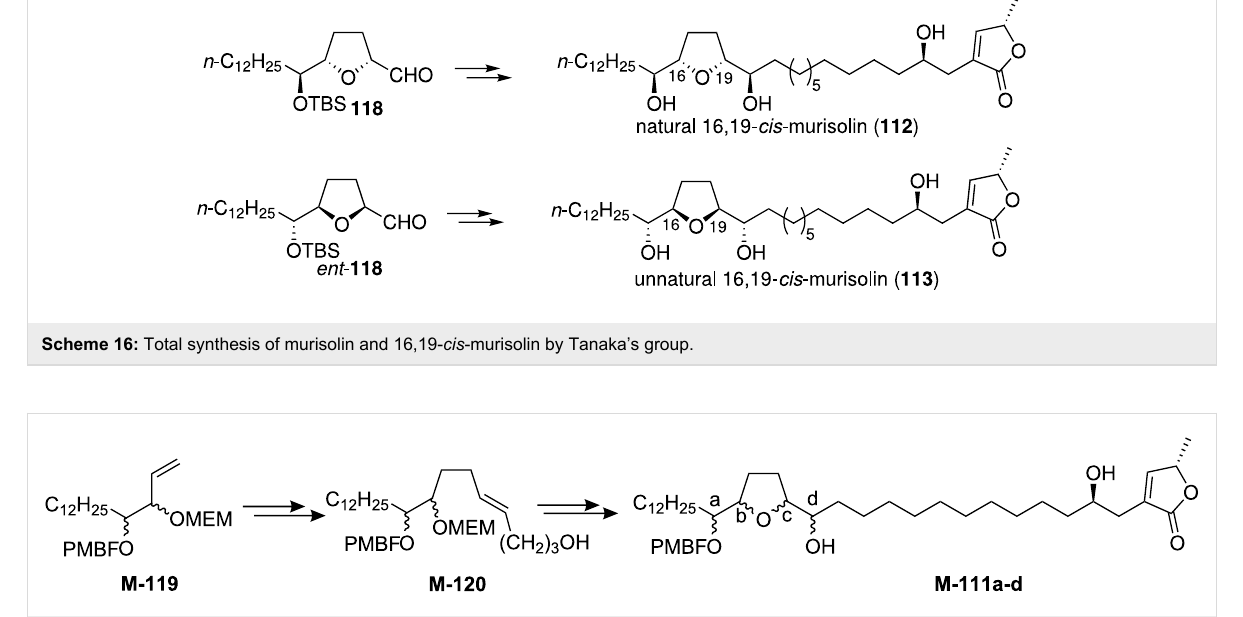
Total synthesis of